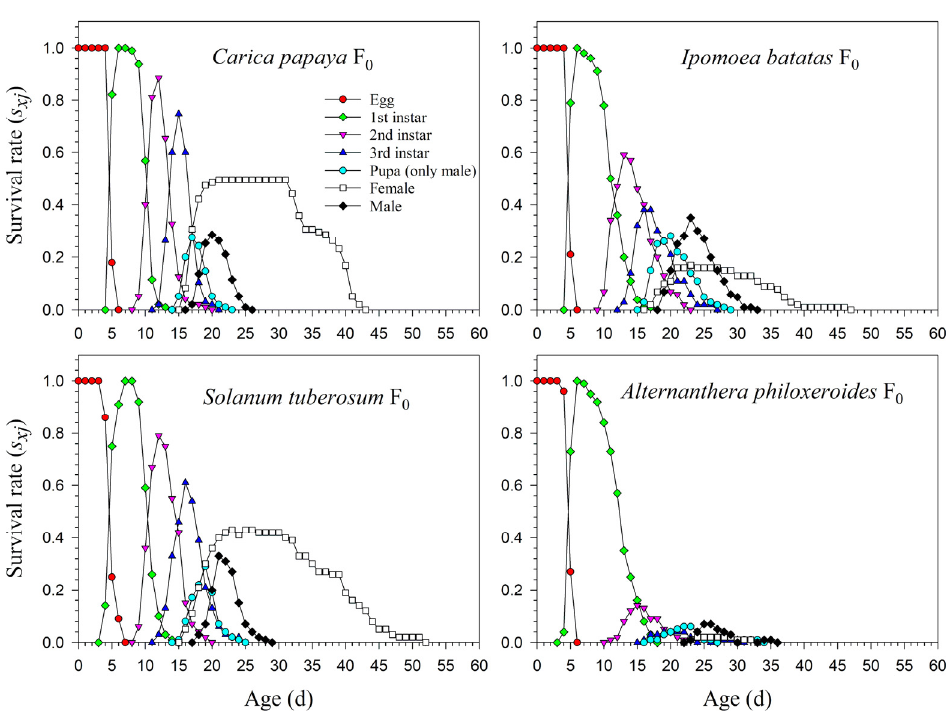
Figure 1. Age-stage-specific survival rates ( s xj ) of Paracoccus marginatus individuals reared on four different host plants (F 0 ). Table 2. Preadult survival rates ( s a ), proportions of female adults ( N f /N ), proportions of male adults ( N m / N ), and fecundity rates ( F ) of Paracoccus marginatus individuals reared on four different host plants (F 0 –F 2 ).